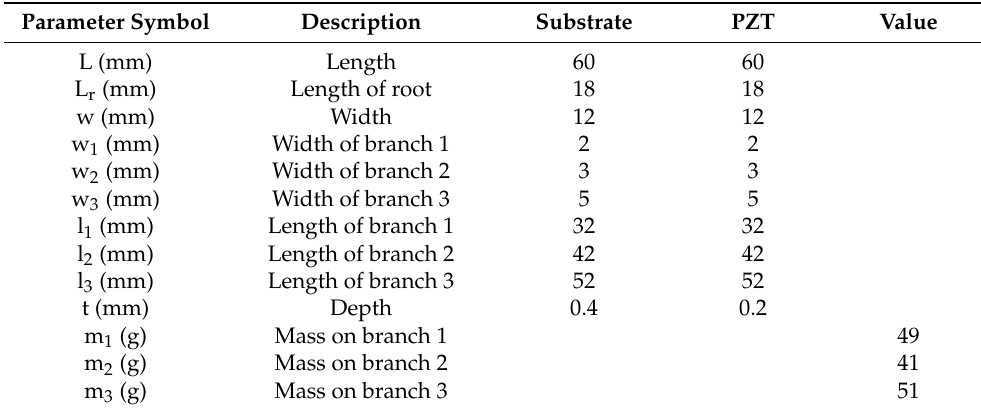
Table 2. Parameters of the proposed SCMEH.